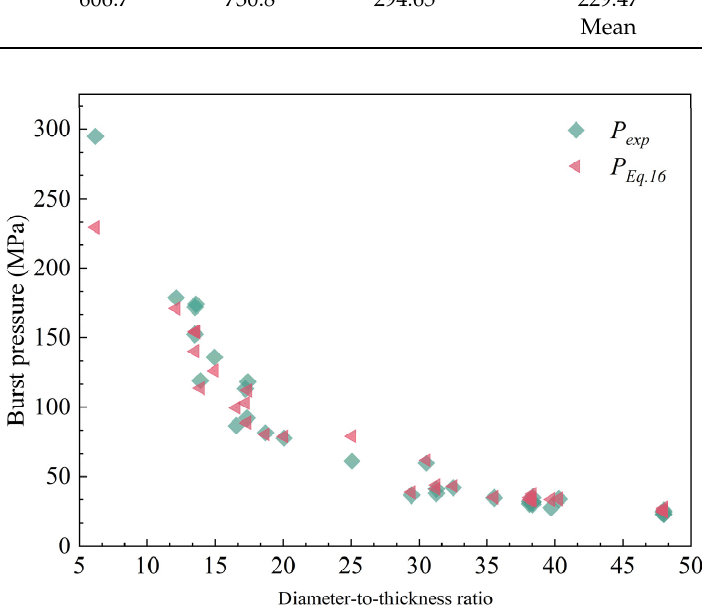
Figure 6. Comparison of predictions with experiments.